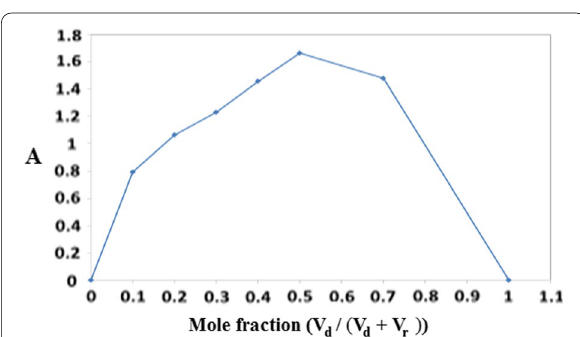
Fig. 7 Job’s method for the reaction between MBTH and TIG in the presence of 1%Ce (IV) as